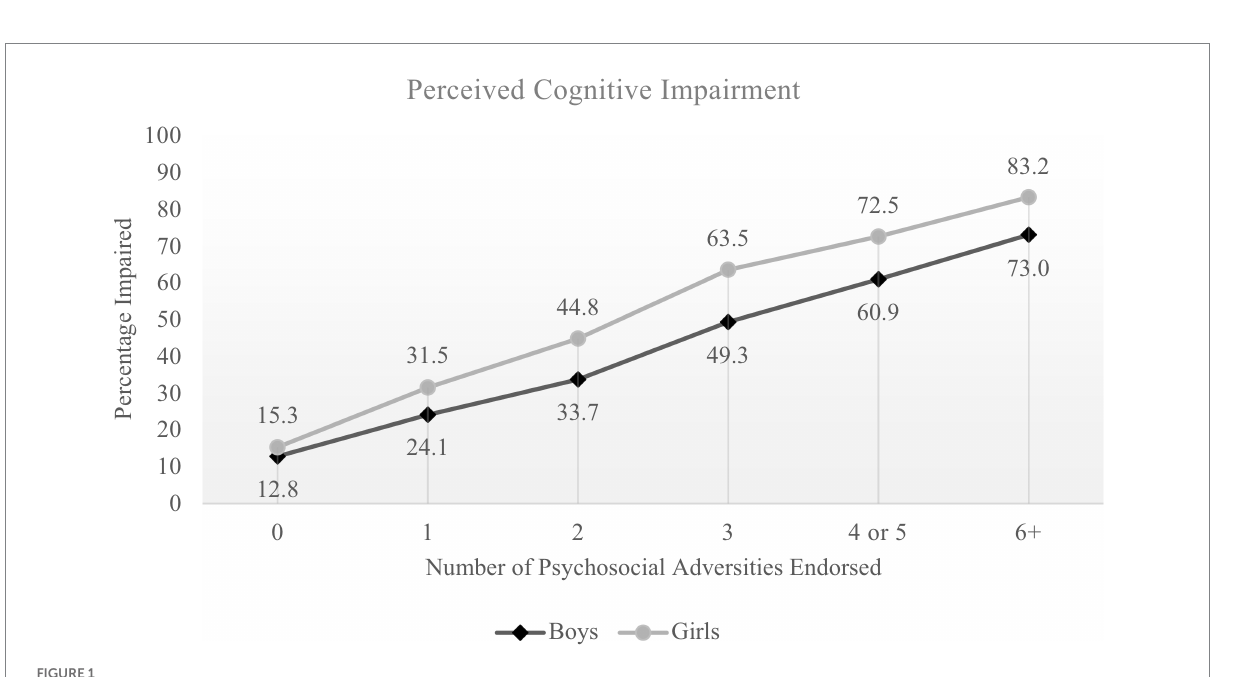
FIGURE 1 Percentages endorsing perceived cognitive impairment stratified by number of psychosocial adversities experienced. The 11 questions comprising the psychosocial adversity index are marked with an asterisk in Tables 1, 3.